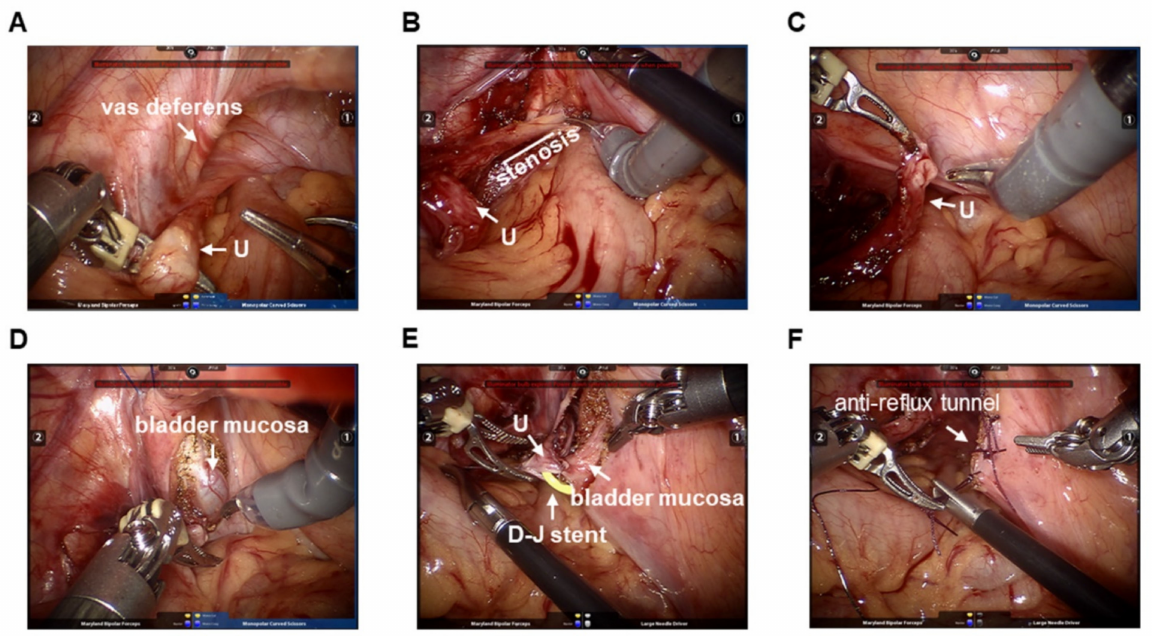
Figure 2. Surgical steps of RMLUR for DUS in children. ( A ) Insertion of ureter in bladder. ( B ) Ureter is dissected distally to the point where stenosis exists and maintained periureteral blood supply. ( C ) Ureter is transected near the area of the stenosis and cut up. ( D ) Incising and separating the detrusor muscle lengthwise for approximately 3 cm to expose the vesical mucosa. ( E ) Placing multi- coil Double-J stent in the ureter and bladder. ( F ) Detrusor muscle is closed by a 2-0 interrupted suture for an anti-reflux